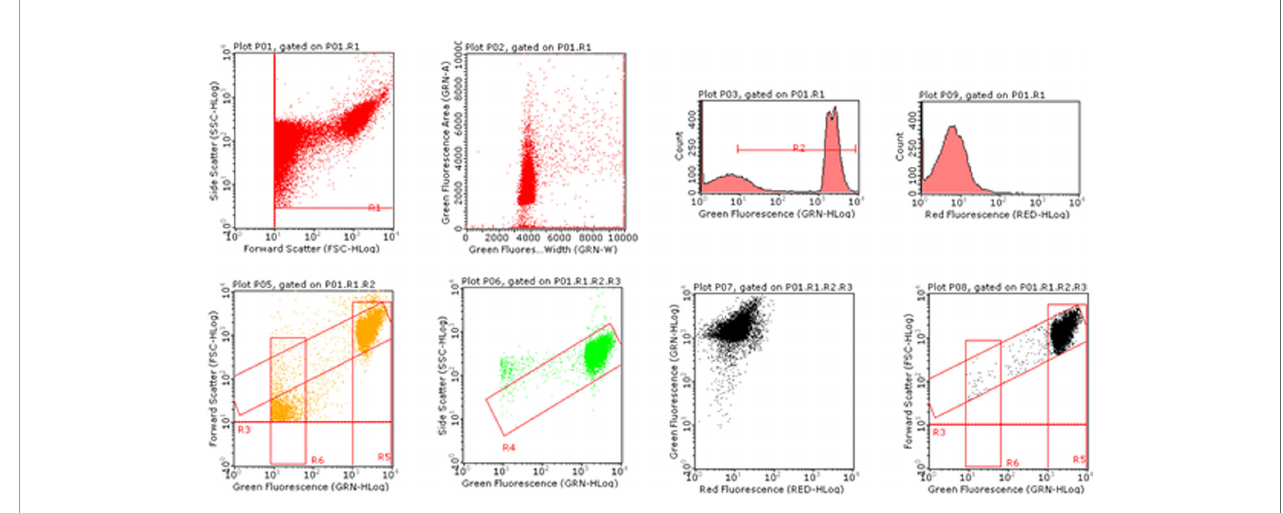
FIGURE 1 | Image of bivariate plots of nuclei and MNs analyzed by Guava Incyte